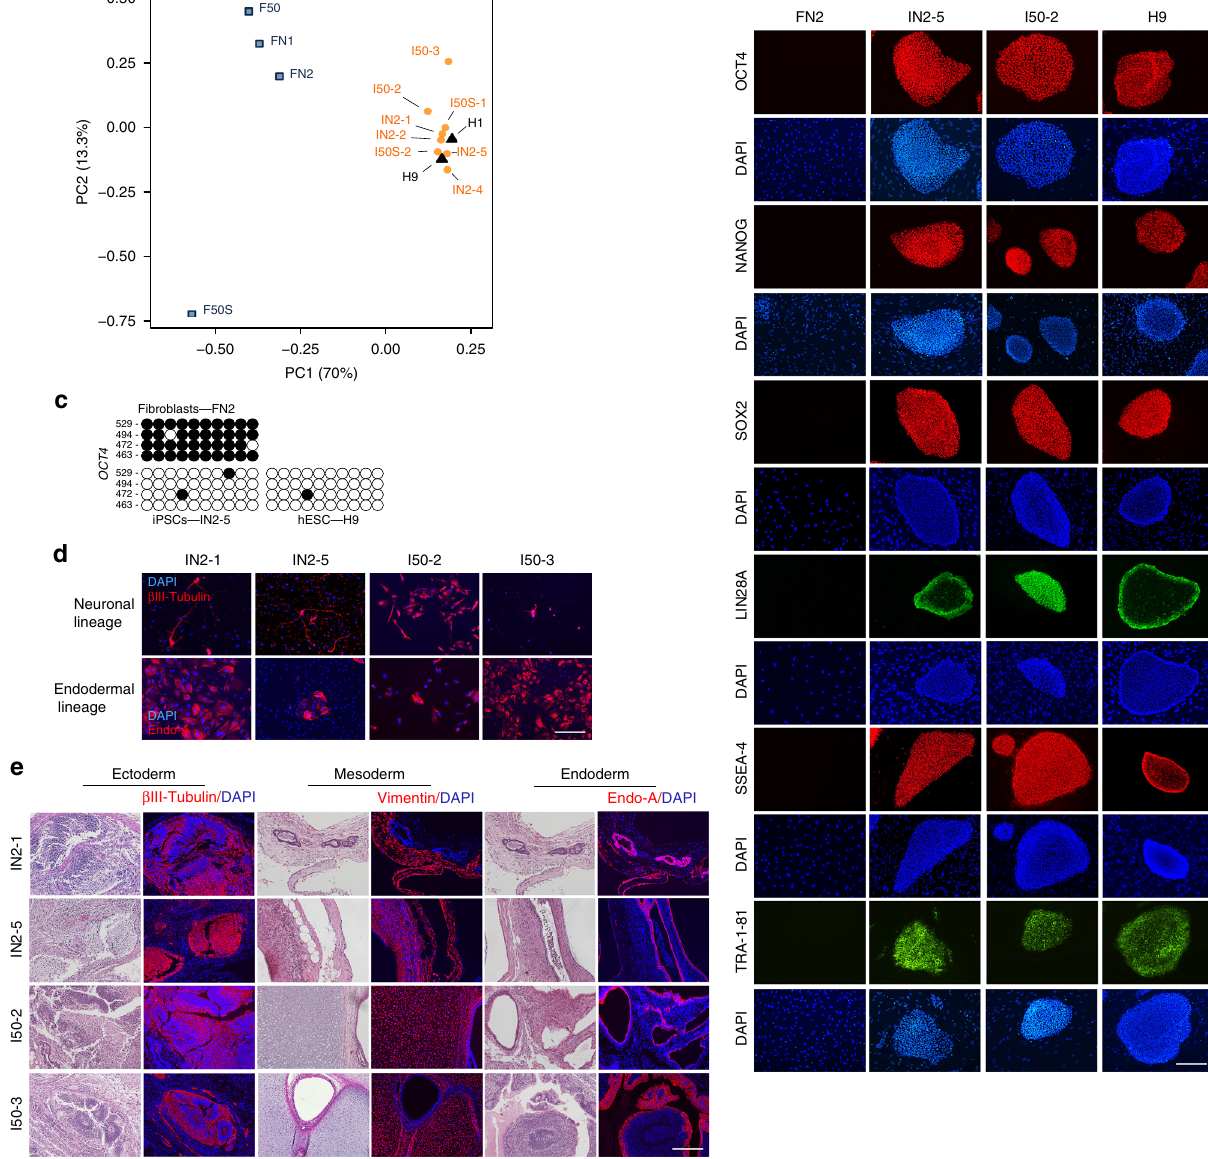
Fig. 6 Characterization of the pluripotency of selected iPSC lines. a Principal component analysis of the RNA-Seq gene expression data performed on selected iPSC lines (orange circles) and their corresponding parental fi broblasts (blue squares), as well as on two human ESC lines (H1 and H9, black triangles), documenting the close clustering of iPSCs with H1 and H9. All IN2 iPSC lines were derived from FN2, I50 from F50, and I50S from F50S (see also Supplementary Table 1). b Immuno fl uorescent analysis showing expression of selected pluripotency markers in the indicated iPSC lines. H9 human ESCs and FN2 fi broblasts are included as positive and negative controls, respectively. See Fig. 5c and Supplementary Figs. 11 and 12 for the analysis of additional iPSC lines. c Bisul fi te sequencing of the OCT4 promoter region in a selected iPSC line and its parental fi broblast line. H9 human ESCs are included as a control. The closed circles indicate methylated sites of the analyzed region. d Immunostaining showing expression of the neuronal marker β III-Tubulin (TUJ1) (ectoderm), and the endoderm-speci fi c cytokeratin Endo-A in the indicated iPSC lines subjected to directed differentiation. e Hematoxylin and eosin staining and immuno fl uorescent analysis of consecutive sections of teratomas derived from indicated iPSC lines showing histology and marker expression speci fi c to ectoderm ( β III-Tubulin (TUJ1), neural tissues), mesoderm (vimentin, connective tissues), and endoderm (Endo-A, endothelium). See Fig. 5e and Supplementary Fig. 13 for teratoma analysis of additional iPSC lines. All scale bars, 250 µ